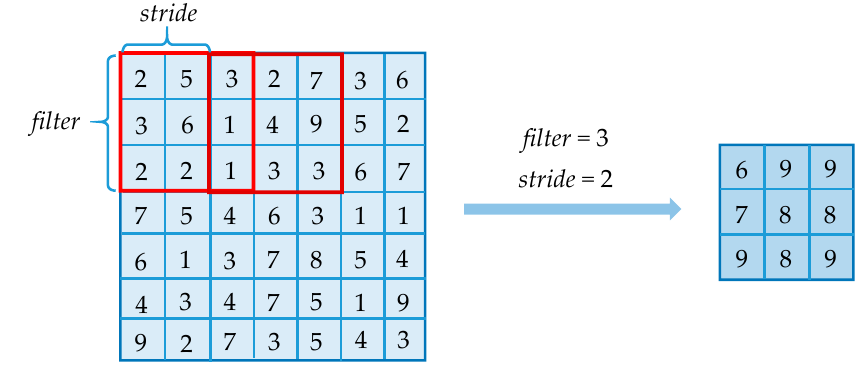
Figure 3. Max pooling process. Get the maximal value in the range of each pooling operation.